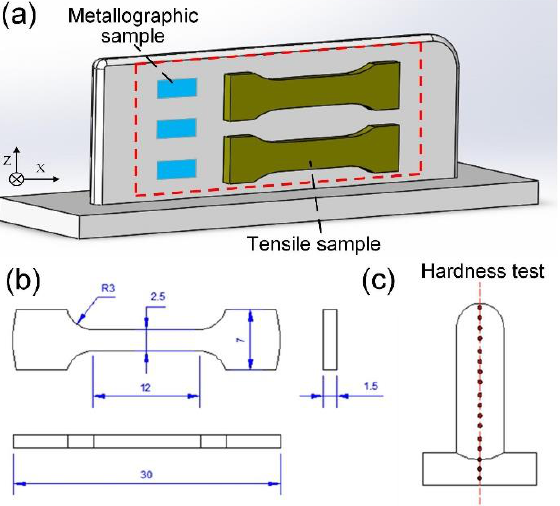
Figure 2. ( a ) The position of metallographic and tensile samples; ( b ) the dimension of tensile test specimens; ( c ) the position of the hardness test.